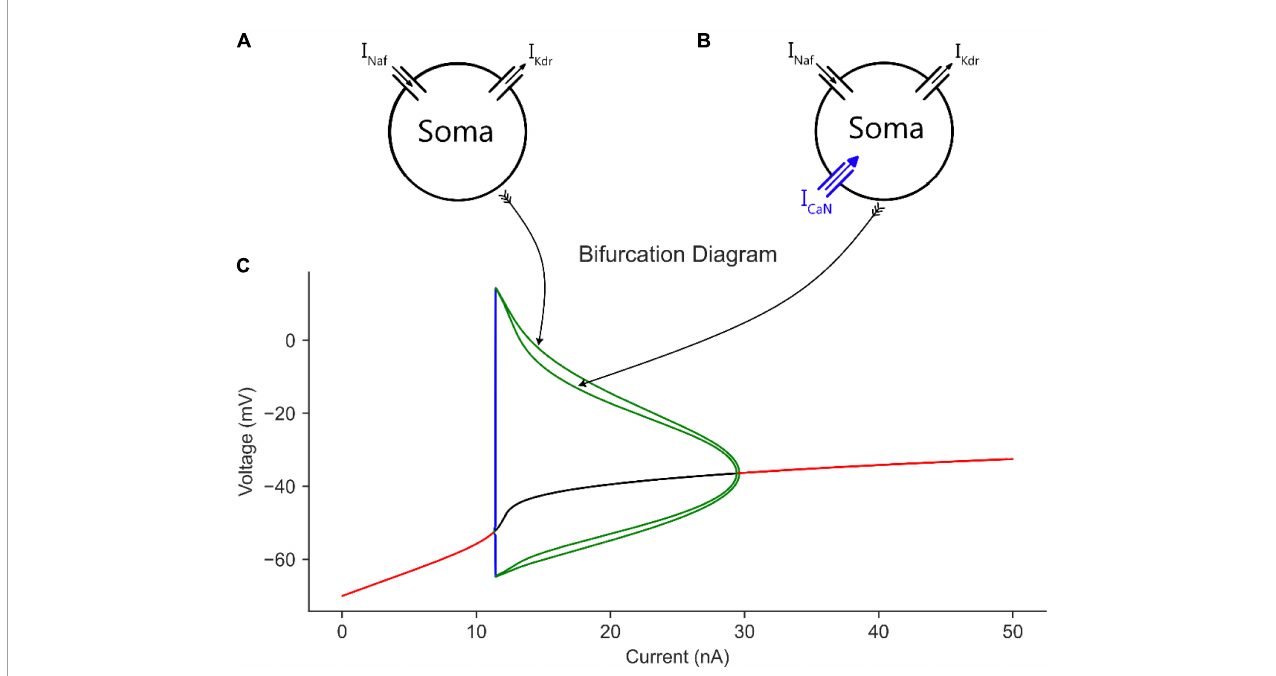
FIGURE2 The effect of somatic CaN channels on the MN model bifurcation diagram. (A) The soma model with leak, Na, and K channels only. (B) The soma model in A with CaN channels added. (C) The bifurcation diagram of the soma models with and without CaN channels.